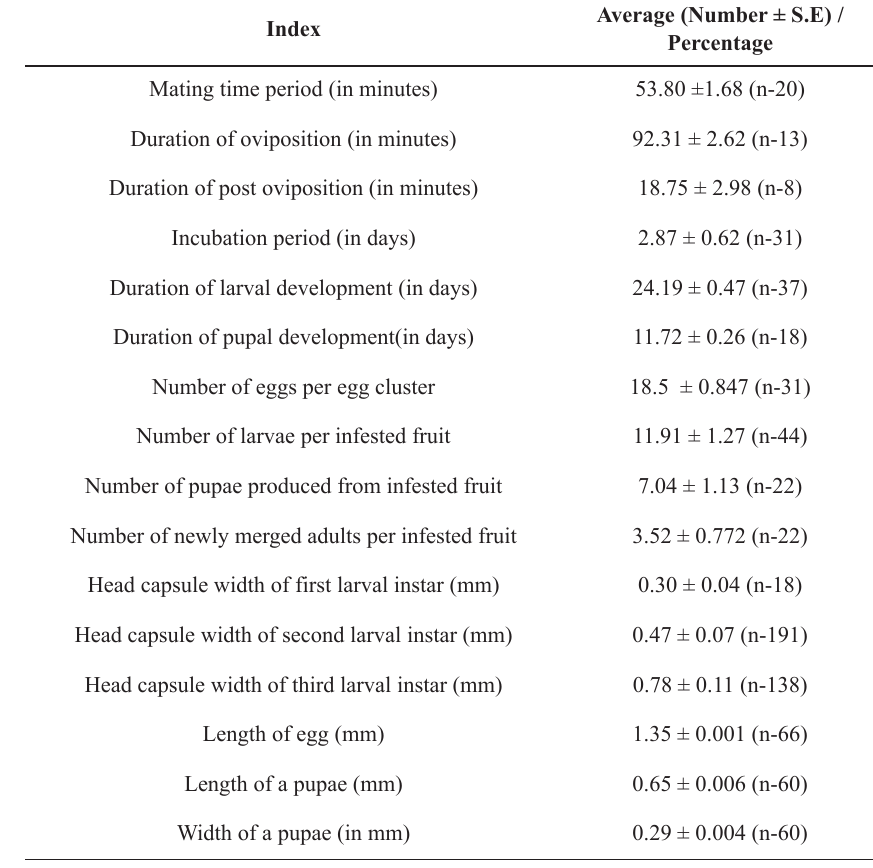
Table 3 : Life history data, field incident data and reproductive data of D.